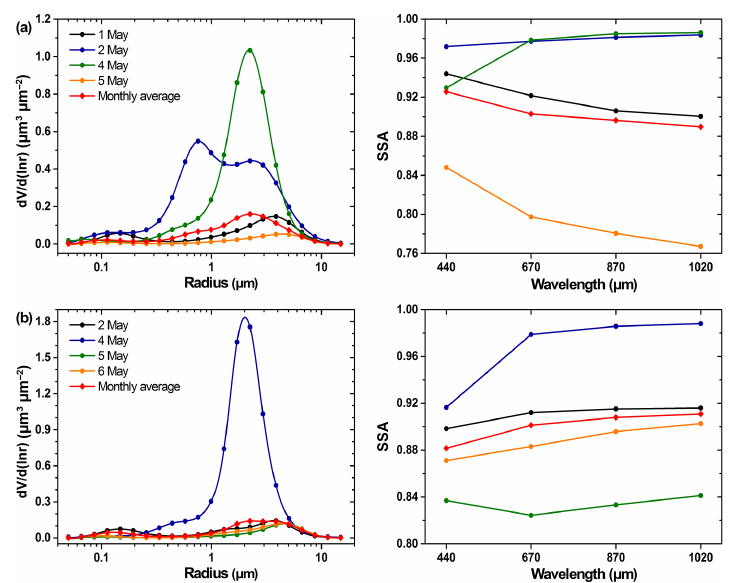
Figure 14. Variations in the daily aerosol volume size distribution and spectral SSA during the dust event at (a) AOE_Baotou and (b) Beijing. Different colours represent different days, and the red curves represent the average VSD and SSA in May 2017. There was no VSD and SSA inversion product for Xuzhou-CUMT and Ussuriysk sites during 3–8 May